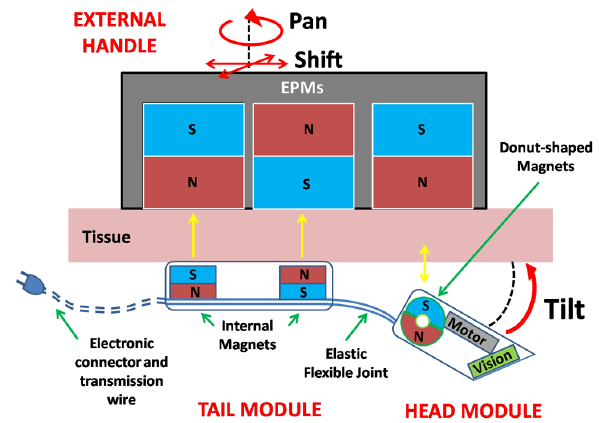
Figure 2. Schematic representation of the entire robotic endoscope with the compliant MLS. The interaction between internal and ex- ternal magnets and the 4 related degrees of freedom are underlined by yellow and red arrows,